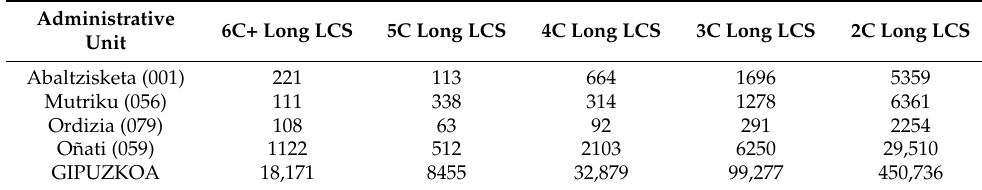
Table 2. Number of data pairs found using the “longest_common_substring” (LCS) operator, sorted by string